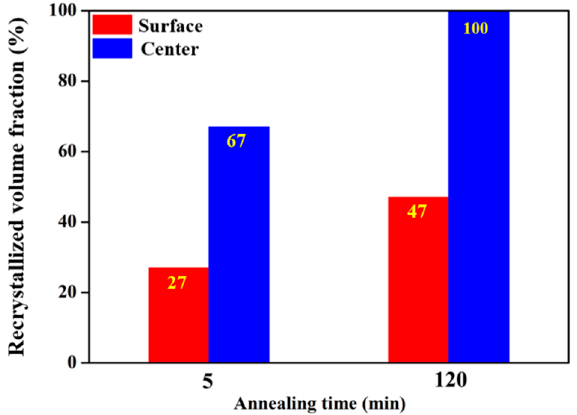
Figure 5. Recrystallization volume fraction of the surface and central layers of 70% clock-rolled Ta with different annealing times at 950 °C.